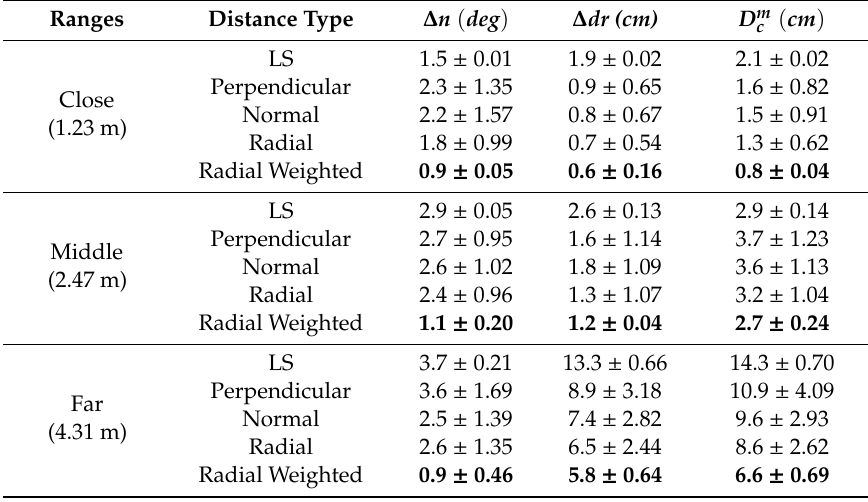
Table 2. Mean value of metrics for the di ff erent operating ranges. LS: